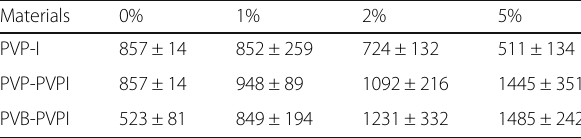
Table 1 The average diameter of PVP/I, PVP/PVPI, and PVB/PVPI fibers with different doping concentrations of iodine and PVPI, with unit of nanometer